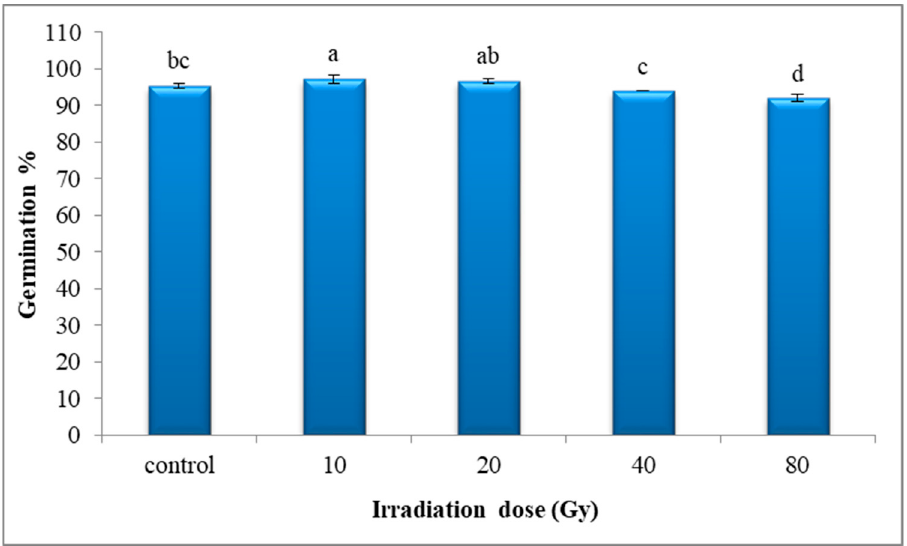
Figure 1. The germination percentage of red radish seeds affected by gamma-rays at different dose levels. Findings are means ± standard deviations (n = 3) at p ≤ 0.05, and different letters indicate significant differences. Bars point to standard deviations.